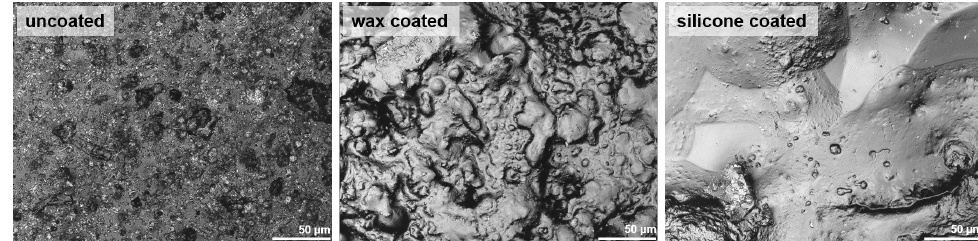
Figure 4. Laser scanning microscope images of uncoated Poraver ® particles and particles coated with Candelilla wax and SILIXON10